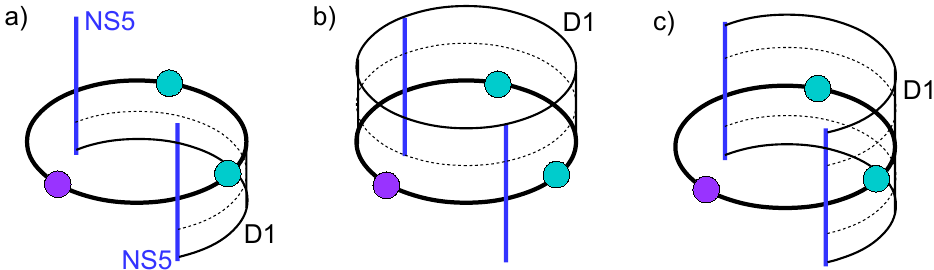
Figure 36 . (a) Brane setup with a semi-in(cid:12)nite D1, inserting v (cid:0)